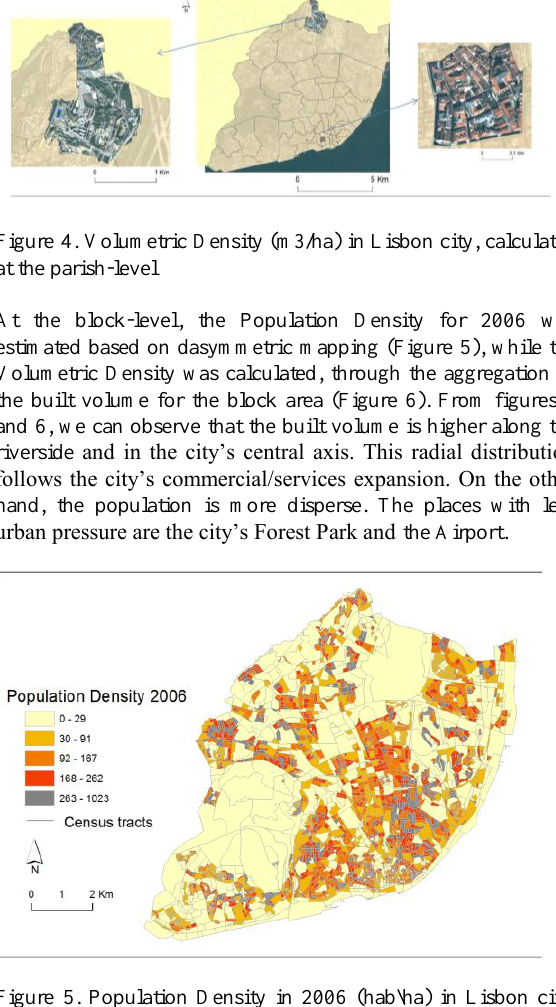
Figure 5. Population Density in 2006 (hab\ha) in Lisbon city, estimated at the block-level